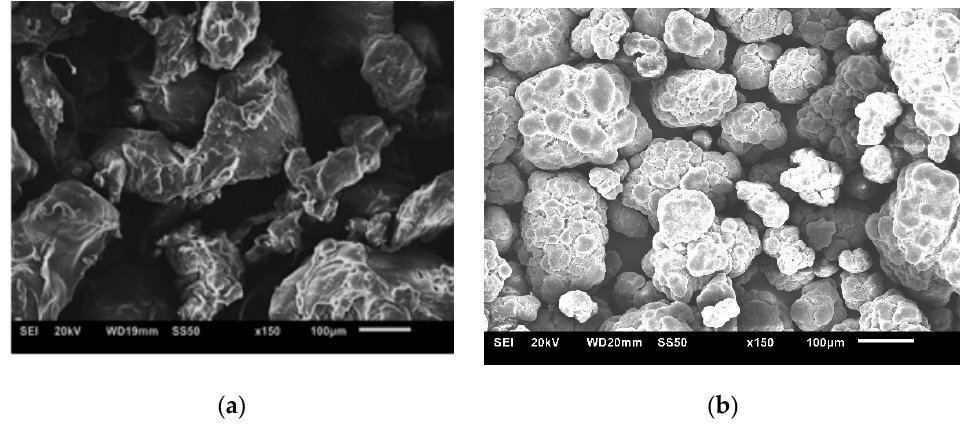
Figure 3. SEM images of pure polymer powders: ( a ) LLDPE; ( b )